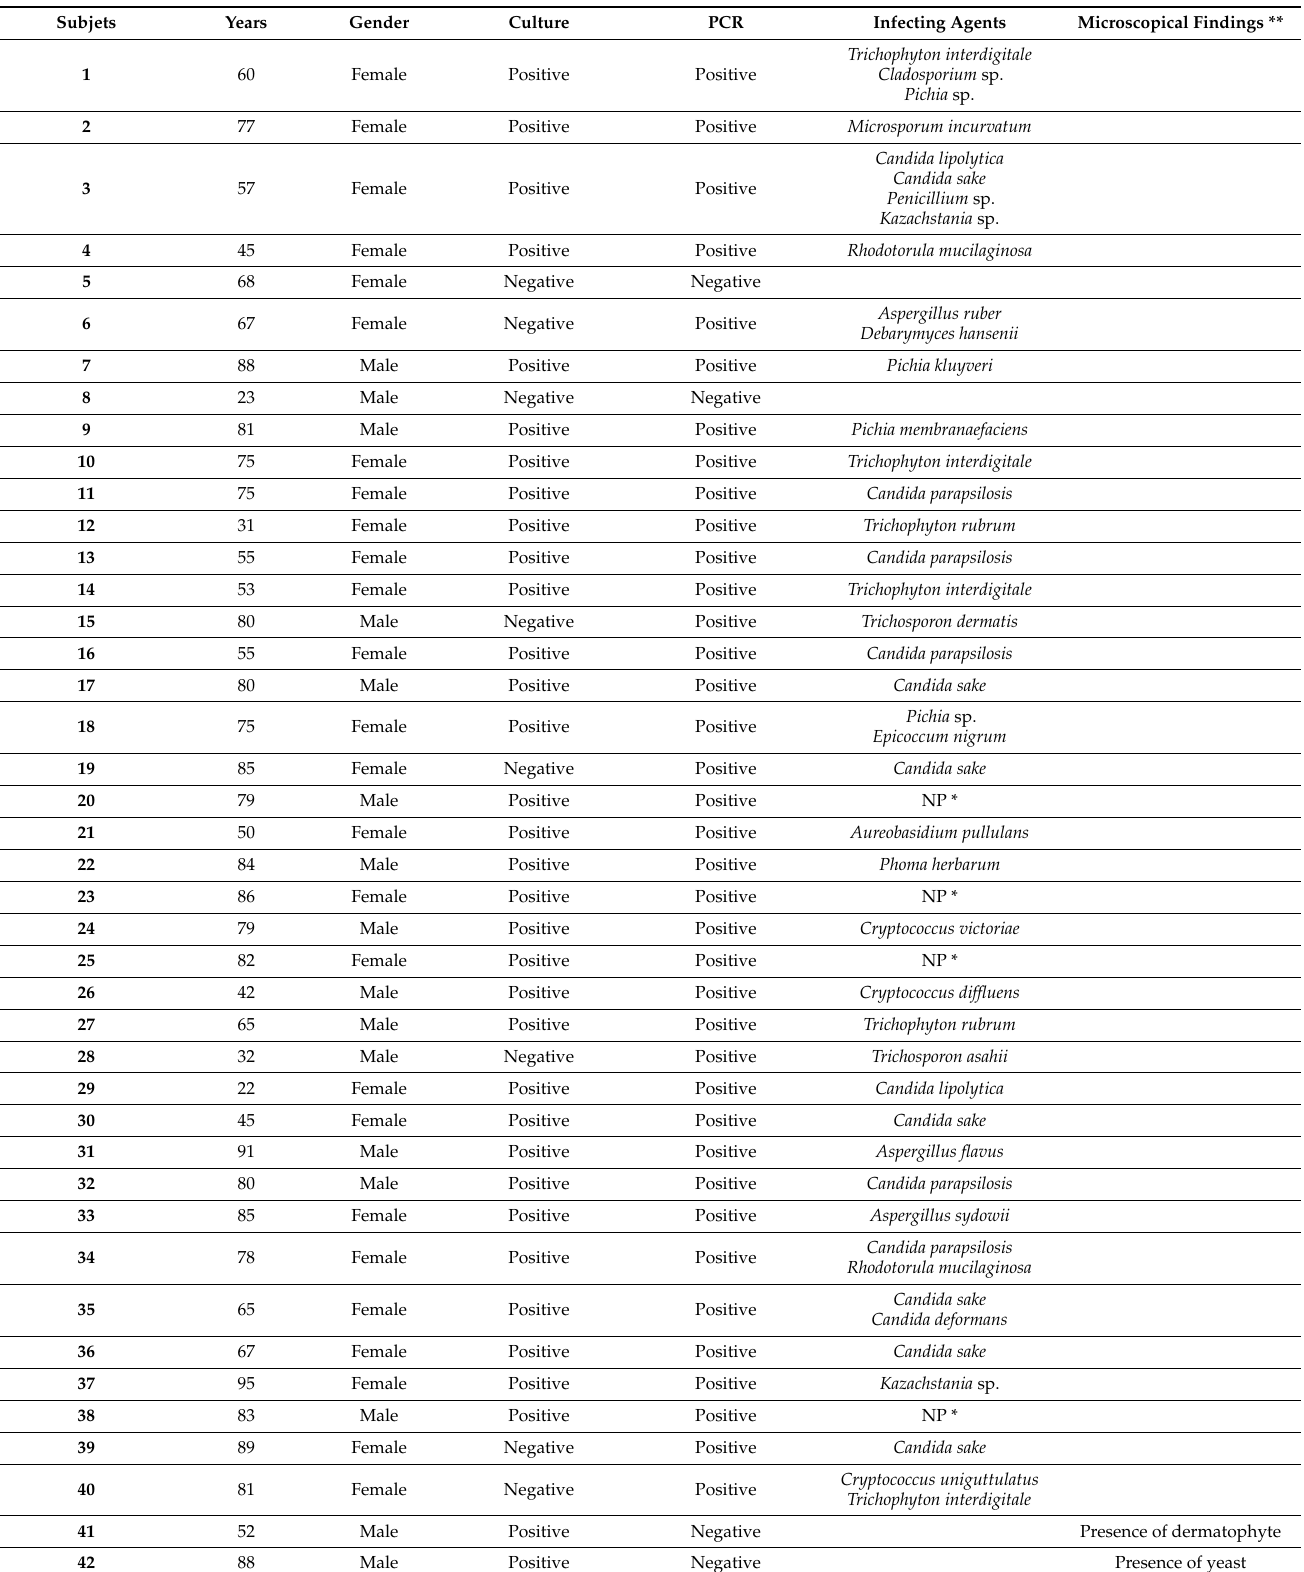
Table 1. Characterization of the population under study, detection of fungal infection in the nails and identification of the fungal